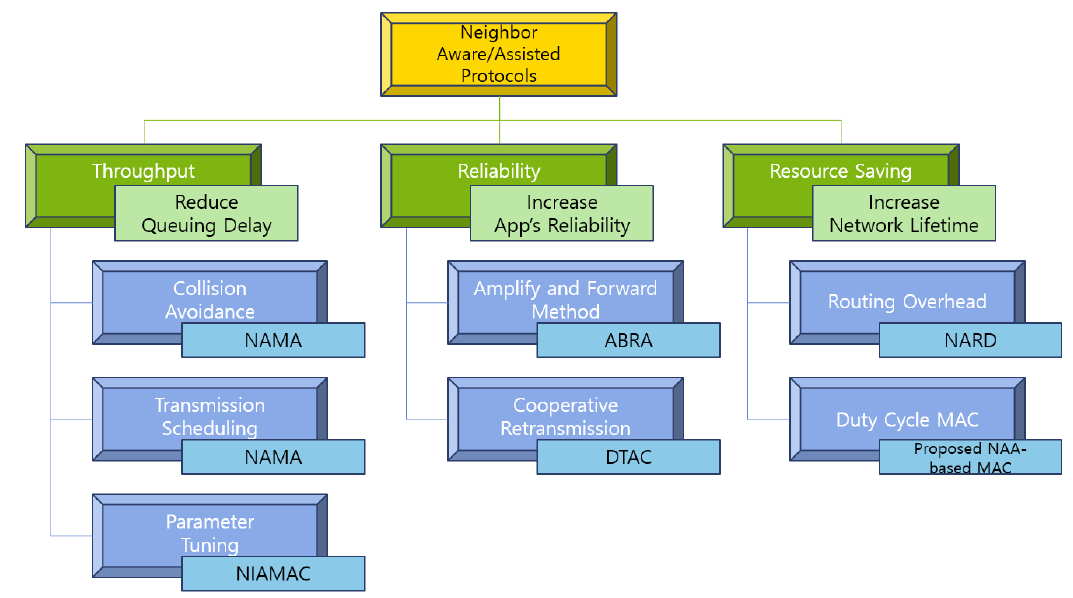
Figure 1. Categorized Neighbor Aware/Assistance (NA)